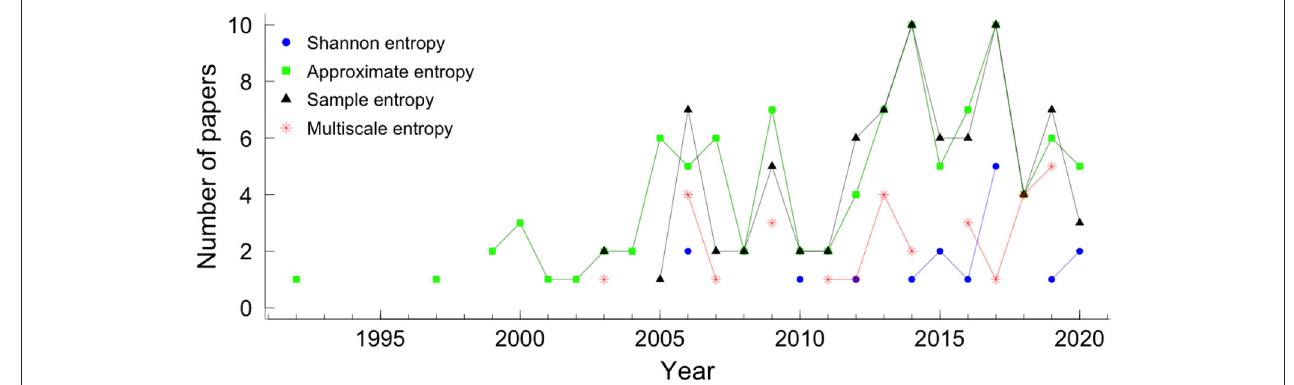
FIGURE 3 | Entropies by year. The colors and symbols represent the different measures of entropy. The blue circle, green square, black triangle, and star red represented Shannon entropy, approximate entropy, sample entropy, and multiscale entropy, respectively.